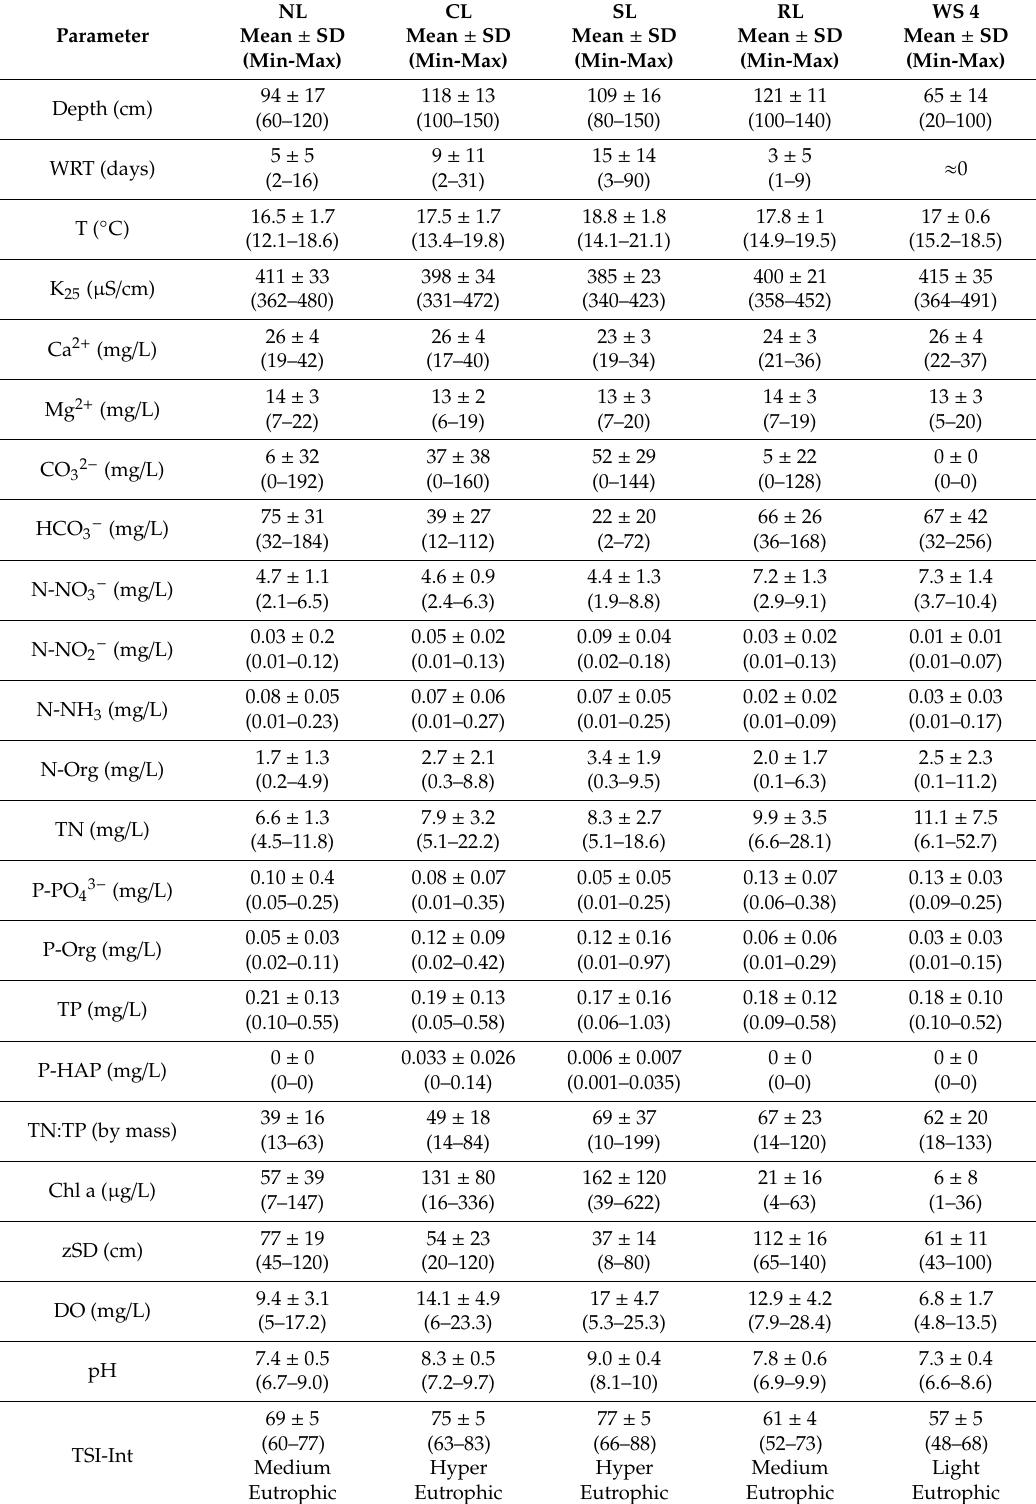
Table 1. Summary of environmental conditions